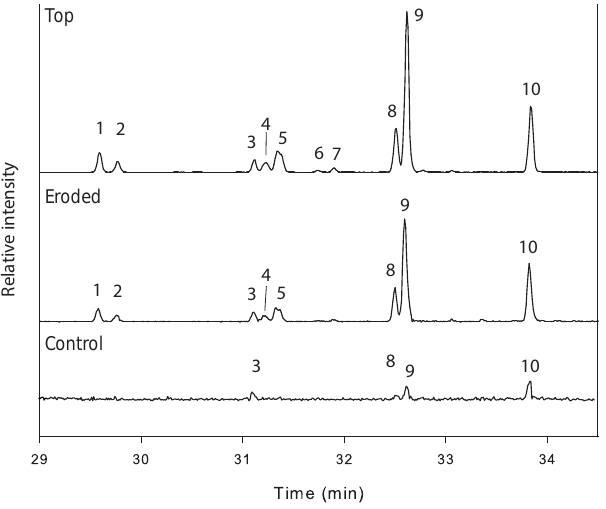
Figure 9. Partial chromatogram ( m/z = 215) showing exam- ples of characteristic hydrolysed lipid extracts from the top section of the soil slope, the eroded sediment (taken from the 10 ◦ , 60mmh − 1 experiment) and the control soil. Where 1 = coprostanol, 2 = epicoprostanol, 3 = 5 α -cholestanol, 4 = 5 β - campestanol, 5 = 5 β -epicampestanol, 6 = 24-ethyl-campestanol, 7 = 24-ethyl-5 β -cholestan-3 α -ol, 8 = 5 β -stigmastanol, 9 = 5 β - epistigmstanol, 10 = 5 α